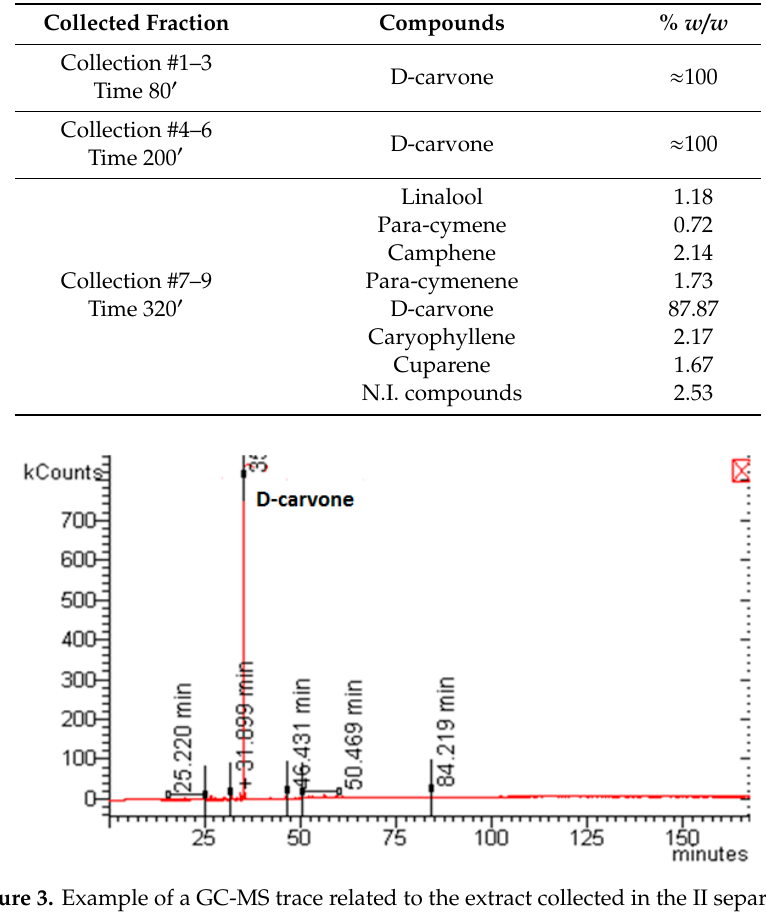
Table 1. Gas chromatography–mass spectrometry (GC-MS) analysis on SFE extracts obtained at 100 bar and 40 °C.